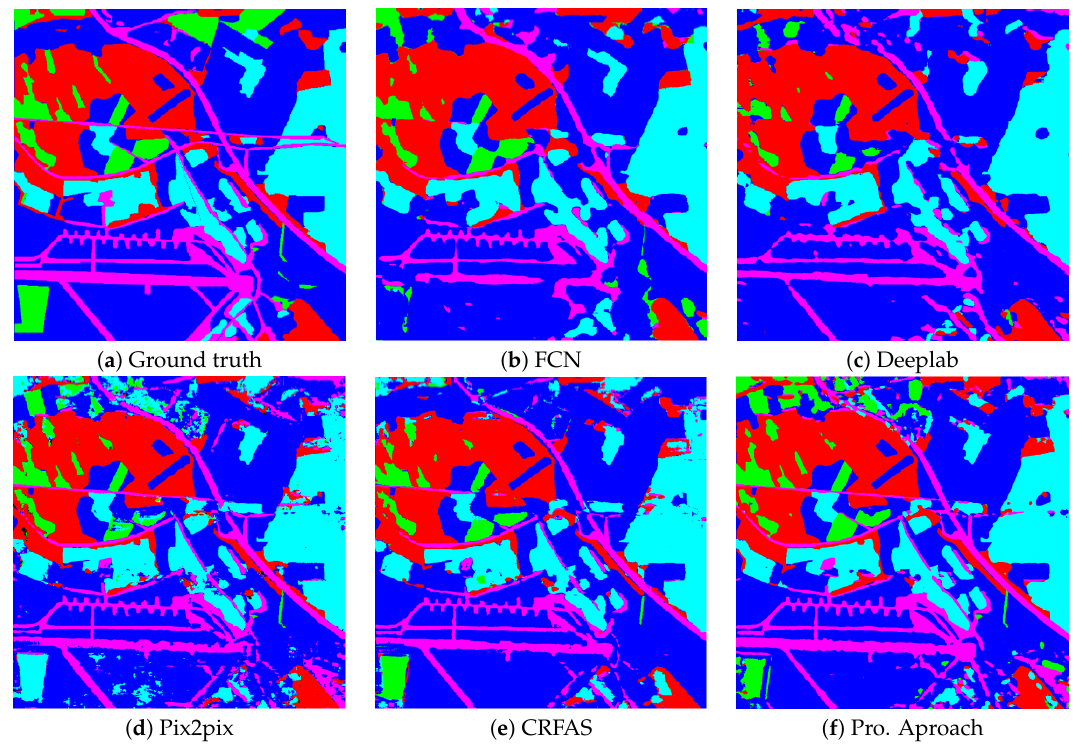
Figure 9. Segmentation results of the ESAR image. ( a ) The ground truth; ( b – d ) the results by FCN, Deeplab, and Pix2pix, respectively; ( e , f ) the results by CRFAS and the proposed approach.